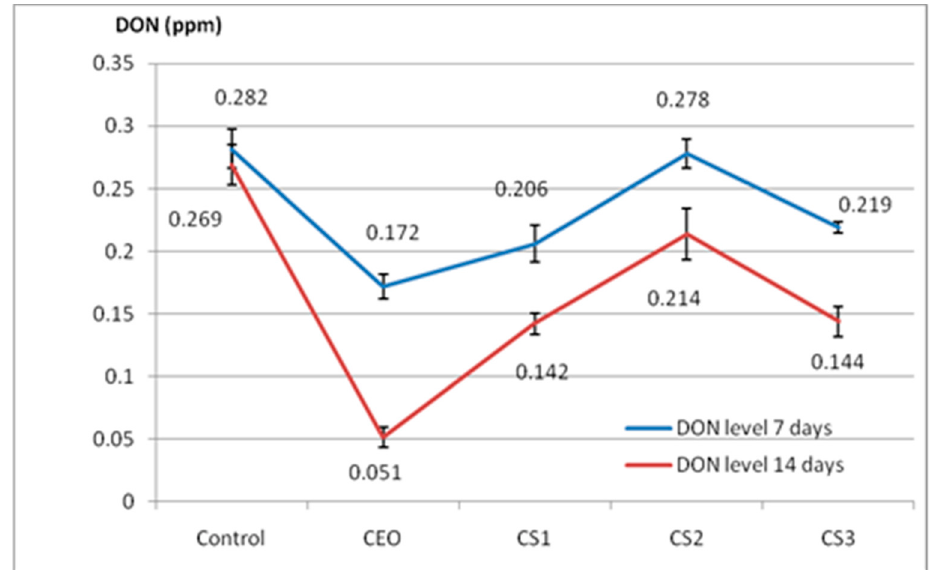
Figure 3. Deoxynivaleno (DON) levels (ppm) in wheat seeds determined after 7 and 14 days of fumigation with essential oil. CEO (0.6%), CS1 (CEO 10% + SEO 2%), CS2 (CEO 1% + SEO 0.2%), CS3 (0.5% + SEO 0.1%). Data are mean ± SD, n = 3.